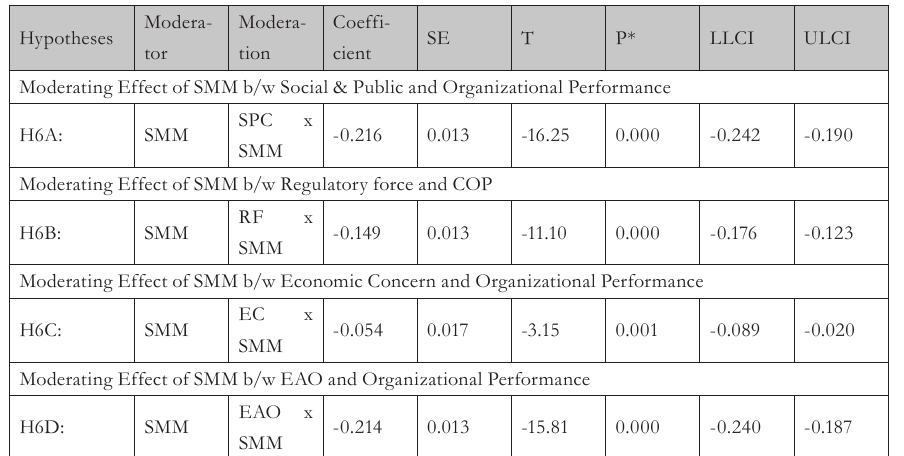
Tab. 5 – Moderating Effect. Source: own